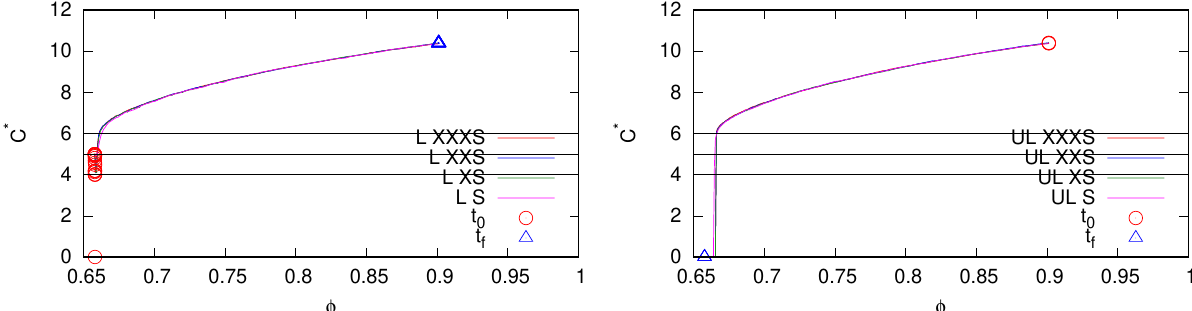
Figure 3. Coordination number, C ∗ (without rattlers), plotted against volume fraction, from the same simulations as in Fig. 1 with same colors / symbols. The three horizontal lines indicate the levels C = 4, 5, and 6, where the jamming / un-jamming, here, occurs at C ∗